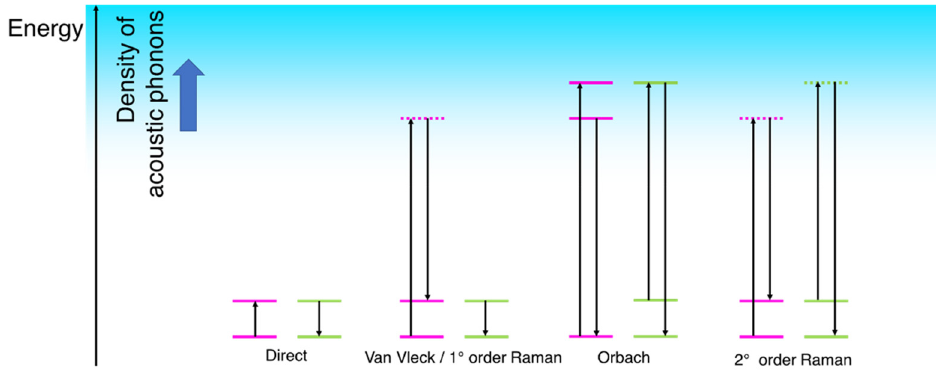
Figure 4. Summary of the mechanisms that can cause an electron spin to relax between two levels (depicted as green lines). Magenta lines are energy levels within the lattice. The dashed lines indicate virtual states. The cyan shading indicates the increased density of states of phonons for increased energy in the acoustic range.